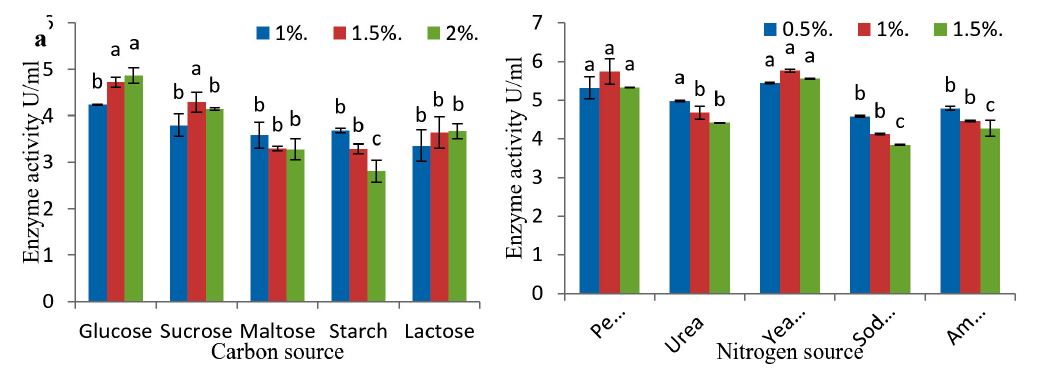
Fig. 5. Effect of (a) carbon and, (b) nitrogen sources on laccase activity using rice bran as a substrate